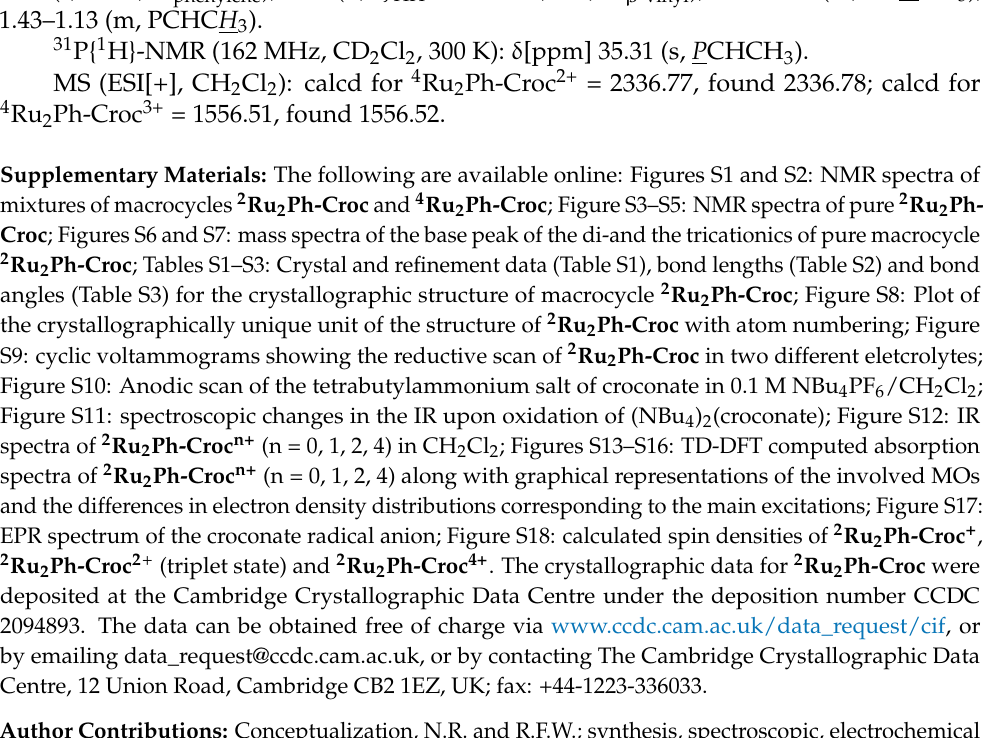
Figure S10: Anodic scan of the tetrabutylammonium salt of croconate in 0.1 M NBu 4 PF 6 /CH 2 Cl 2 ; Figure S11: spectroscopic changes in the IR upon oxidation of (NBu 4 ) 2 (croconate); Figure S12: IR spectra of 2 Ru 2 Ph-Croc n+ (n = 0, 1, 2, 4) in CH 2 Cl 2 ; Figures S13–S16: TD-DFT computed absorption spectra of 2 Ru 2 Ph-Croc n+ (n = 0, 1, 2, 4) along with graphical representations of the involved